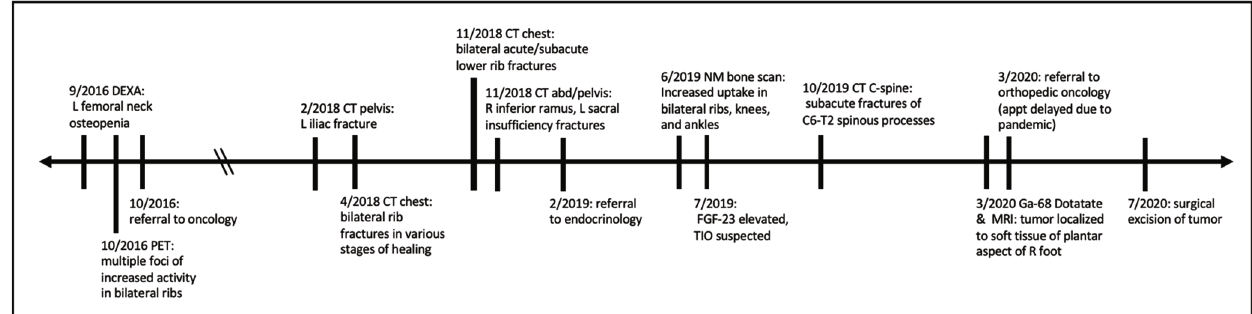
Figure 7: Case 2 timeline. Timeline of the patient ’ s development of TIO symptoms, diagnosis, and treatment for the patient in Case